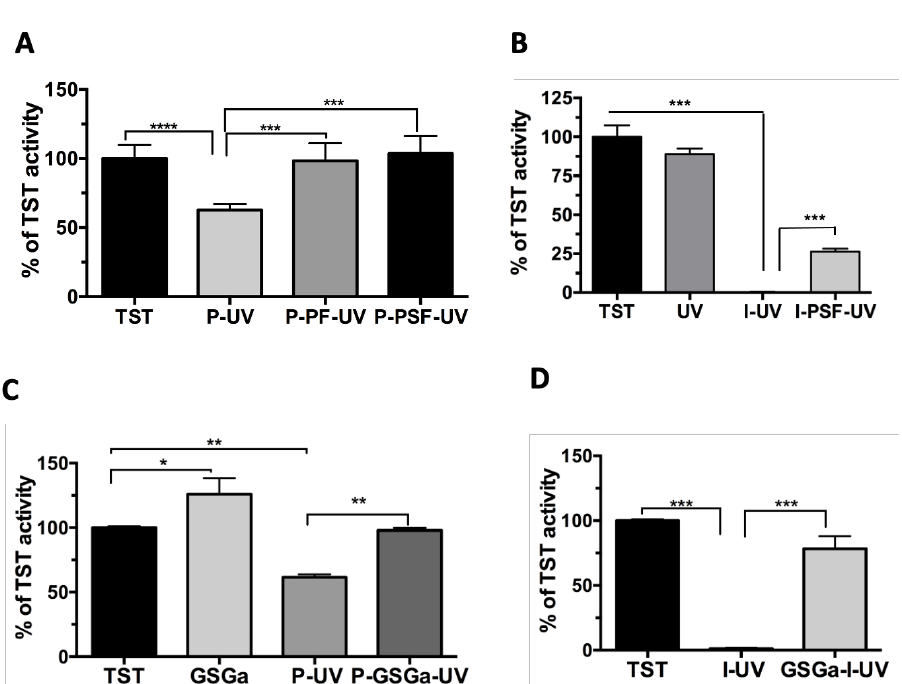
Figure 2. Effects of the photo-polymerization reaction on an enzymatic model. ( A ) Inhibition of 3.9 µ M of TST activity in the presence of 10% ( w/v ) of PEGDA 6 kDa (P) and UV exposure for 5 min and protection of the enzymatic activity by the presence of pegylated proteins 10 mg/mL PEG-fibrinogen (PF) and 28.6 µ M PEG-Silk Fibroin (PSF) in 50 mM Tris-HCl buffer, pH 8.0; ( B ) TST activity in the presence of 1% ( w/v ) of photo-initiator (I) and under UV for 5 min and in the presence of PSF; ( C ) protection from photo-polymerization damage by addition of 10 µ L of GSGa (136 mg (d.w.)/mL) in the solution and ( D ) in the presence of 1% of I ( w/v ). The data were obtained by three or five independent experiments. Error bar indicates S.D. * p value ≤ 0.05; ** p value ≤ 0.01; *** p value ≤ 0.001; **** p value ≤ 0.0001.